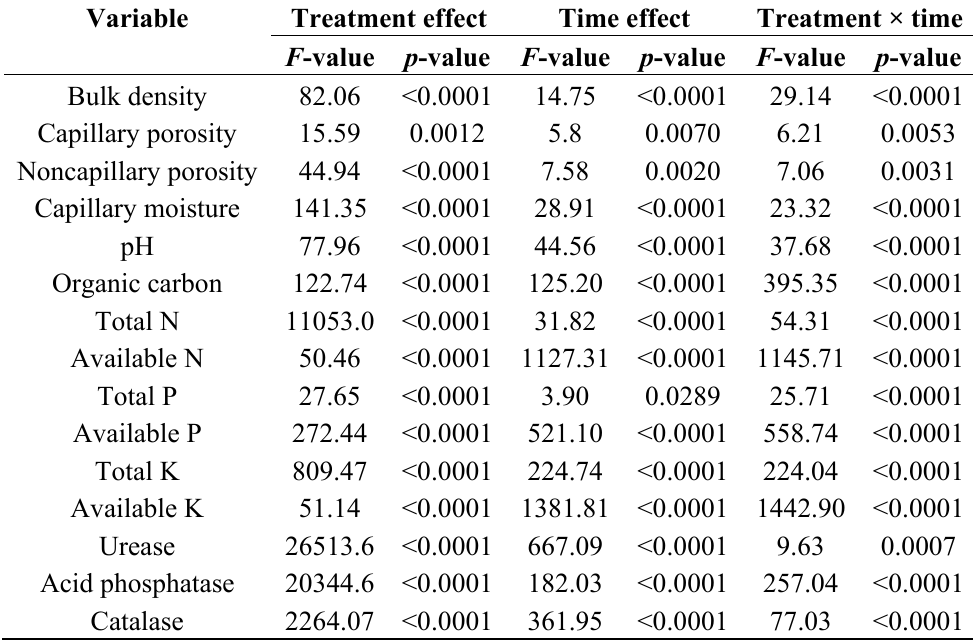
Table 1. Two-way ANOVA results for all measured variables in forest